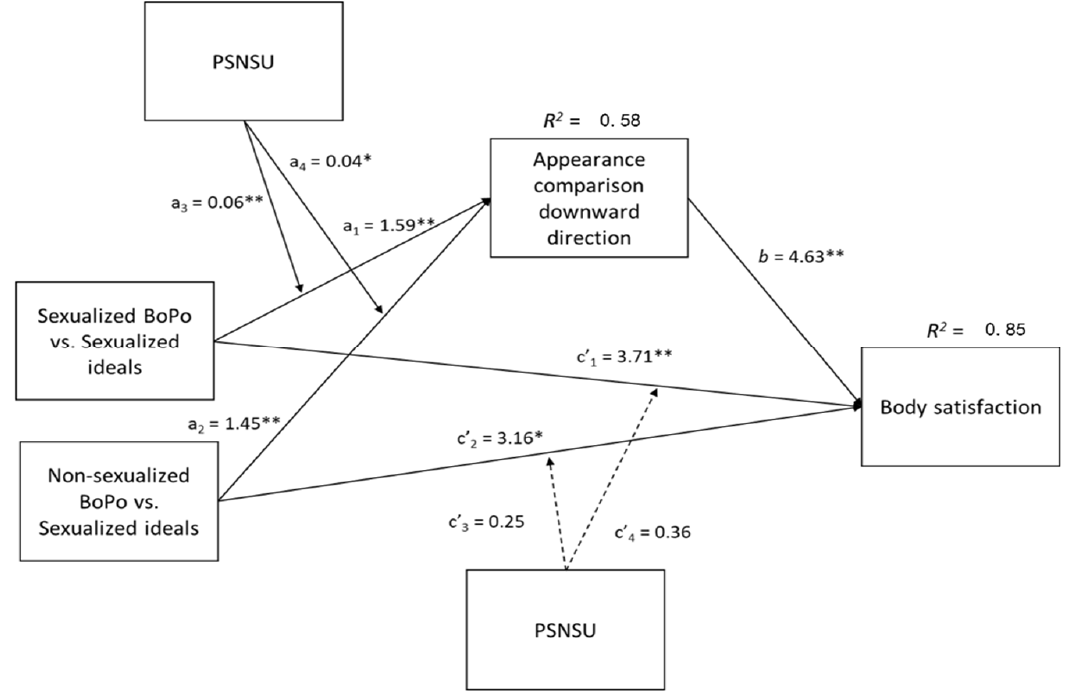
Figure 3. Moderated mediation model on post-exposure body satisfaction. Note: * p < 0.05; ** p < 0.001; Sexualized BoPo = sexualized body-positivity condition; Sexualized ideals = sexualized beauty ideal condition; Non-sexualized BoPo = non-sexualized body-positivity condition; PSNSU = problematic social networking site use; a 1 = sexualized BoPo vs. sexualized ideals on downward appearance comparison; a 2 = non-sexualized BoPo vs. sexualized ideals on downward appearance comparison; a 3 = interaction PSNSU × X1 (sexualized BoPo vs. sexualized ideals) on downward appearance comparison; a 4 = interaction PSNSU × X2 (non-sexualized BoPo vs. sexualized ideals) on downward appearance comparison; c’ 1 and c’ 2 = direct effects on body satisfaction; c’ 3 = interaction PSNSU × X2 (sexualized BoPo vs. sexualized ideals) on body satisfaction; c’ 4 = interaction PSNSU × X1 (non-sexualized BoPo vs. sexualized ideals) on body